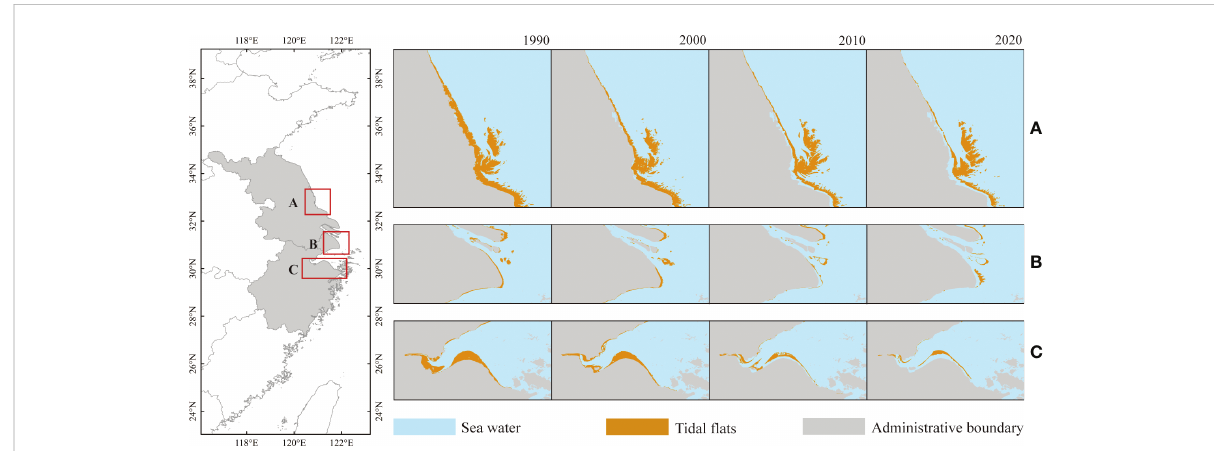
FIGURE 2 Tidal fl at maps for the Yangtze River Delta in the years 1990, 2000, 2010, and 2020. (A) Detection of tidal fl ats in Jiangsu (32 °15 ′ N~34 °15 ′ N, 120 °15 ′ E~121 v45 ′ E). (B) Detection of tidal fl ats in Shanghai (29 °55 ′ N~30 °50 ′ N, 120°30 ′ E~122 °00 ′ E). (C) Detection of tidal fl ats in